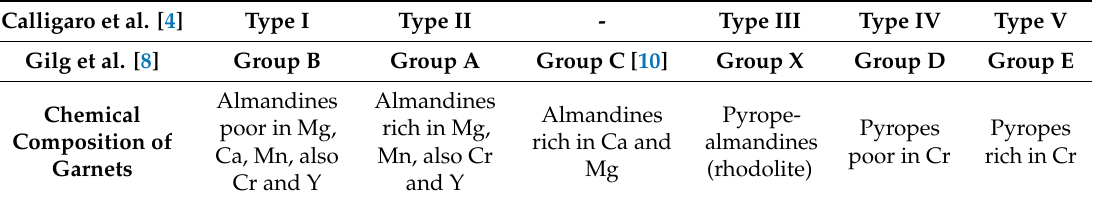
Table 2. Determined groups of garnets from Late Antique–Early Middle age jewellery, according to the definition of Calligaro et al. (2002) [4] and Gilg et al. (2010) [8], based on the chemical composition of